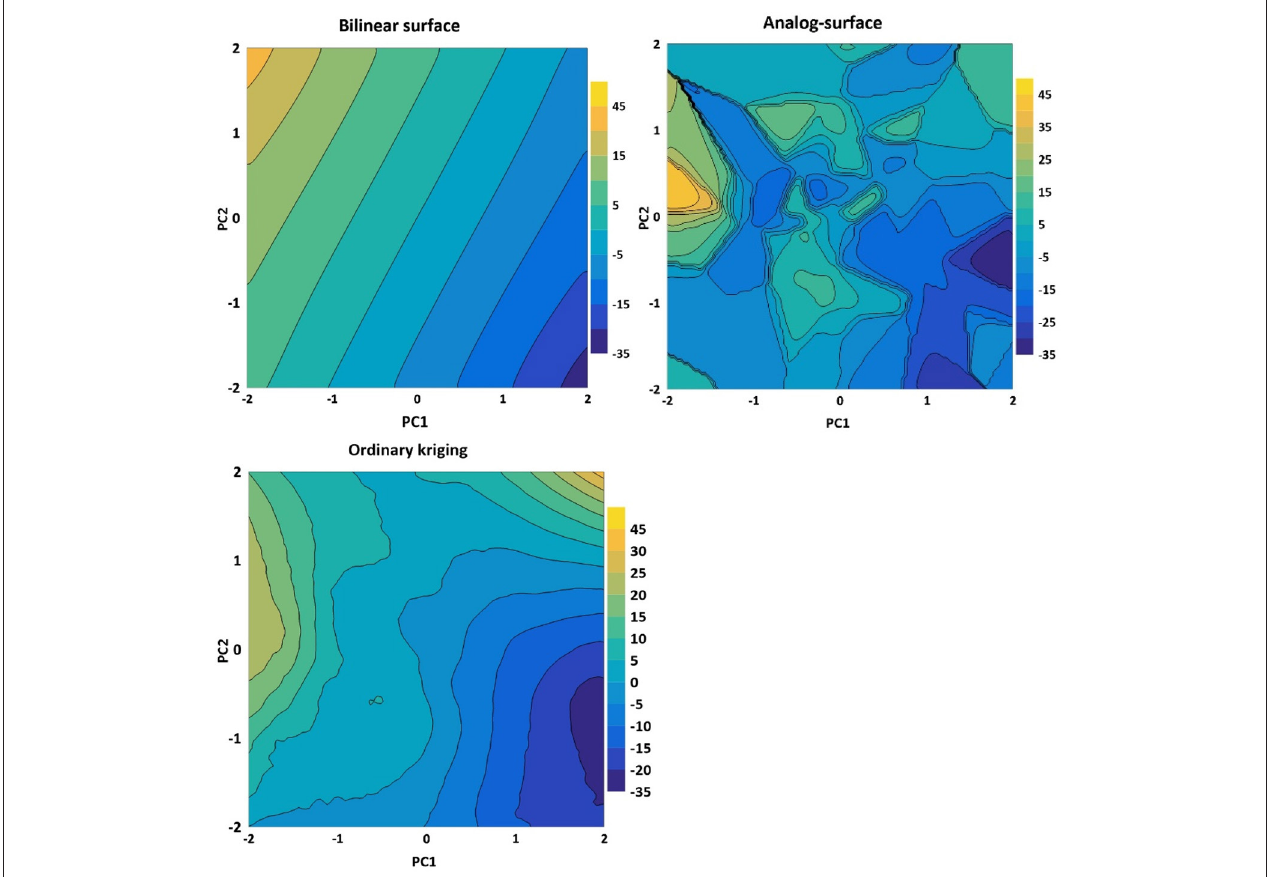
FIGURE 5 | Interpolation of the data points shown in Figure 4 by means of bivariate regression, by an analog approach, and by ordinary kriging. The coordinates are the principal components of the first two EOFs of the barotropic stream function, shown in Figure 3